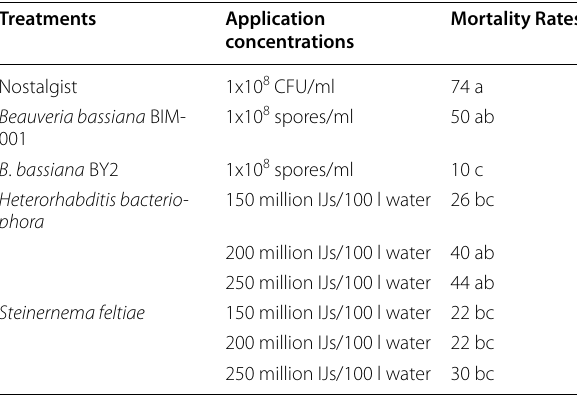
Table 4 Mean numbers of re-isolated 3 rd juveniles from Leptinotarsa decemlineata (Say) pupae Application Concentrations